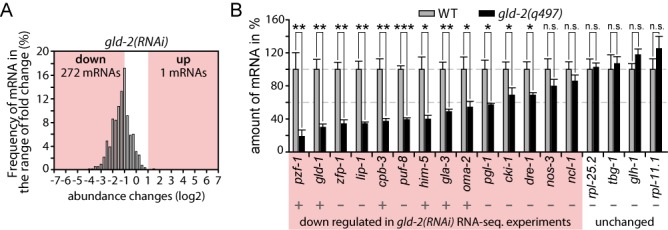
GLD-2-associated mRNAs are less abundant. (A) Abundance changes of 538 previously described GLD-2-associated mRNAs (14) in our gld-2(RNAi) dataset. (B) RT-qPCR measurements of randomly selected down-regulated and unchanged genes, comparing mRNA abundance in gld-2(q497) mutants to wild-type. A plus sign indicates previously proposed GLD-2-associated mRNAs (14). Shown is the mean (±SD) of three independent experiments. Significance was calculated with a Student's t-test: ***, P < 0.001; **, P < 0.01; *, P < 0.05; n.s., not significant.